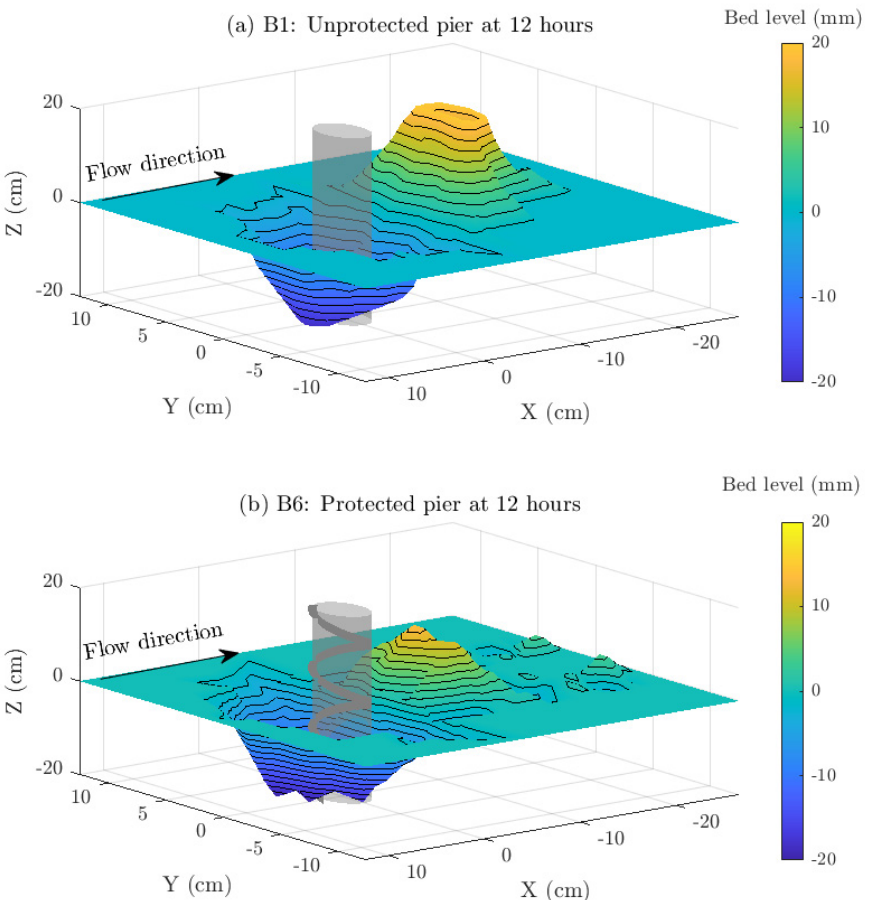
Figure 7. Local scour and deposition patterns for the ( a ) pier without cable and ( b ) cable-wrapped pier for the fine sediment ( d 50 = 0.86 mm) at 12 h. Bed levels are shown as contour levels in millimetres, where the initial bed level is zero, negative values indicate scour, and positive values indicate deposition. The flow direction is from left to right.